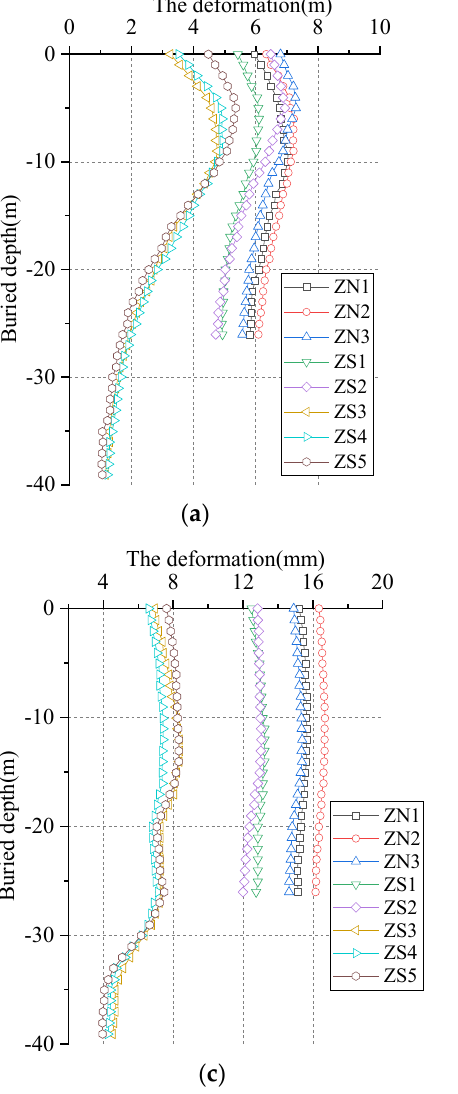
Figure 19. Deformation of the shared retaining structure under working Condition 4. ( a ) excavate to the bottom of the first layer. ( b ) excavate to the bottom of the second layer. ( c ) excavate to the bottom of the foundation pit.